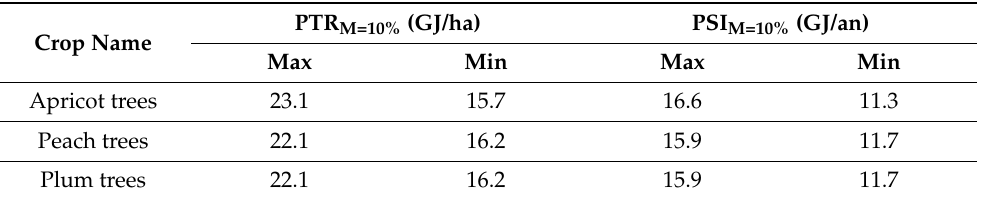
Table 1. The reflection positions of crystal planes and amorphous cellulose forms for the studied wood